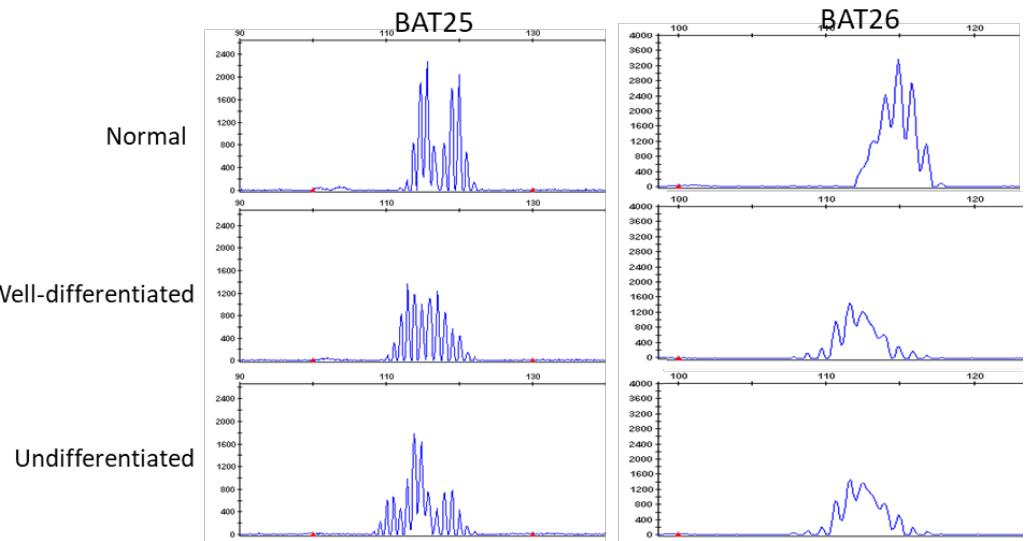
Figure 4. Microsatellite instability (MSI) analysis of normal ( top ), well-differentiated components ( middle ), and undifferentiated components ( bottom ). Two microsatellite markers (BAT25 and BAT26) show instability and are visible as the shift in well-differentiated and undifferentiated components the size (base pairs) of the amplification products.